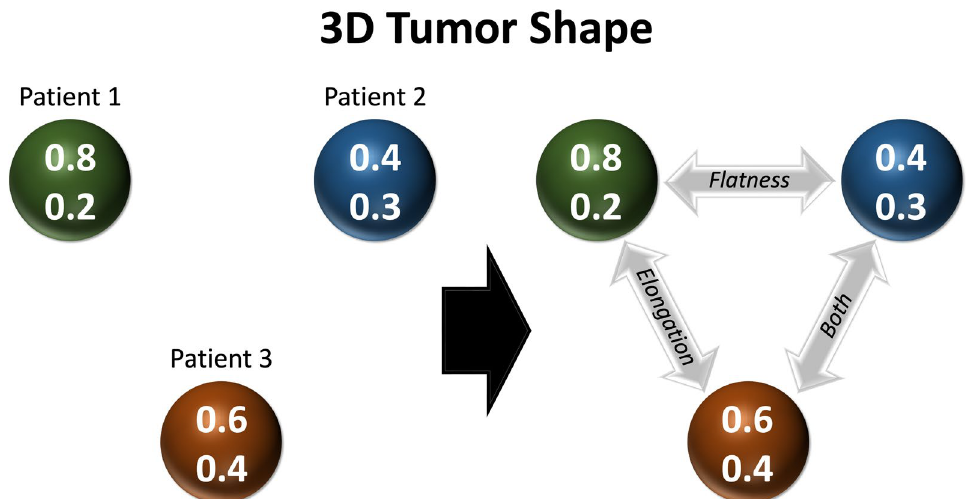
Fig. 2 An example of three patients with varying 3D tumor shapes within a two-dimensional point cloud. In examining characteristics such as elongation and flatness, the points form mutual two-way relationships within a distance or filter characteristic without a three-way relationship. This can be altered by the data scientist, as increasing the distance threshold can increase the points included within a simplicial complex